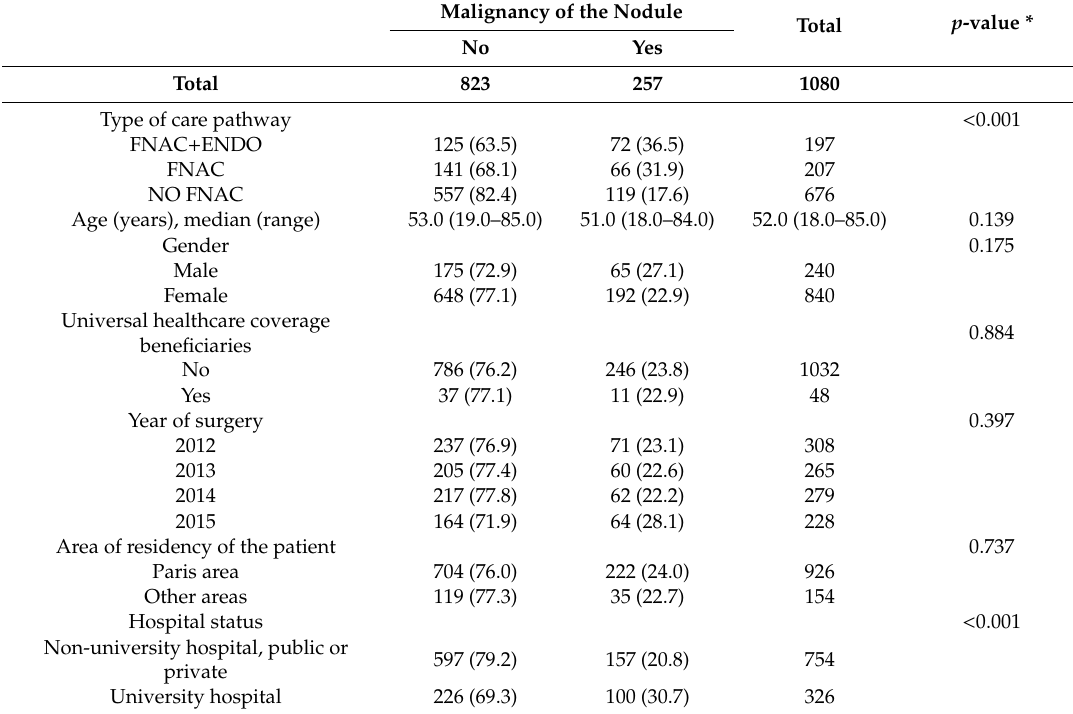
Table 2. Bivariate analysis of factors susceptible to influence thyroid cancer diagnosis among patients operated on for thyroid nodules between 2012 and